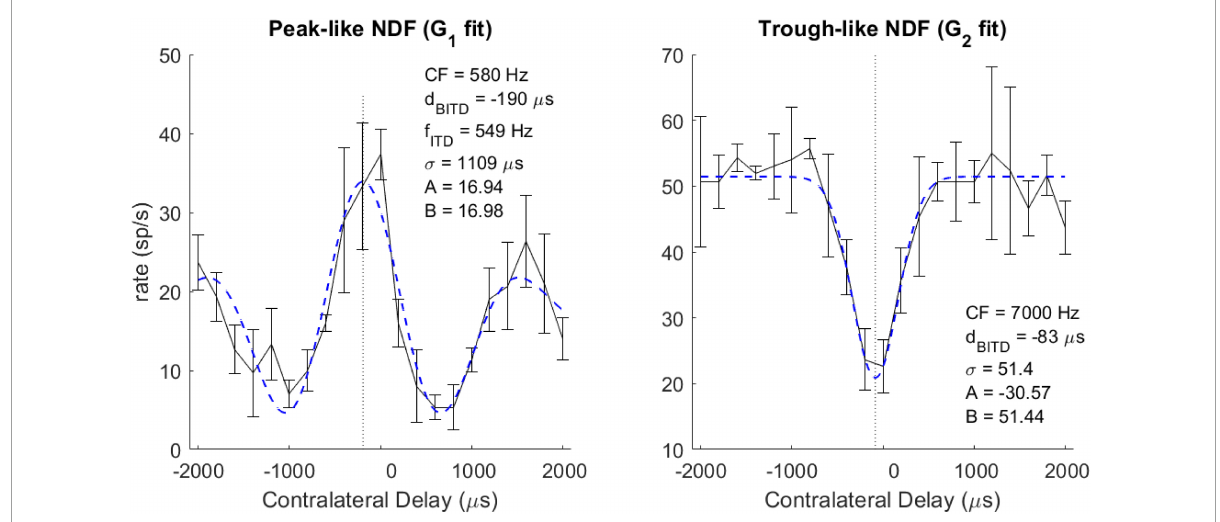
FIGURE1 Example neural ITD responses (black solid curve) and fitted Gabor function (blue dashed curve) for peak-like (left) and trough-like (right) NDFs. Vertical dotted line indicates the best ITD. The neuron’s CF, Best or Worst ITD ( d BITD ), and for cyclic ITD curves, the ITD tuning frequency ( f ITD ) are described in the text.